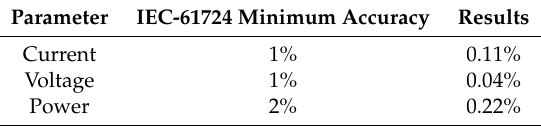
Table 2. Calibration results.